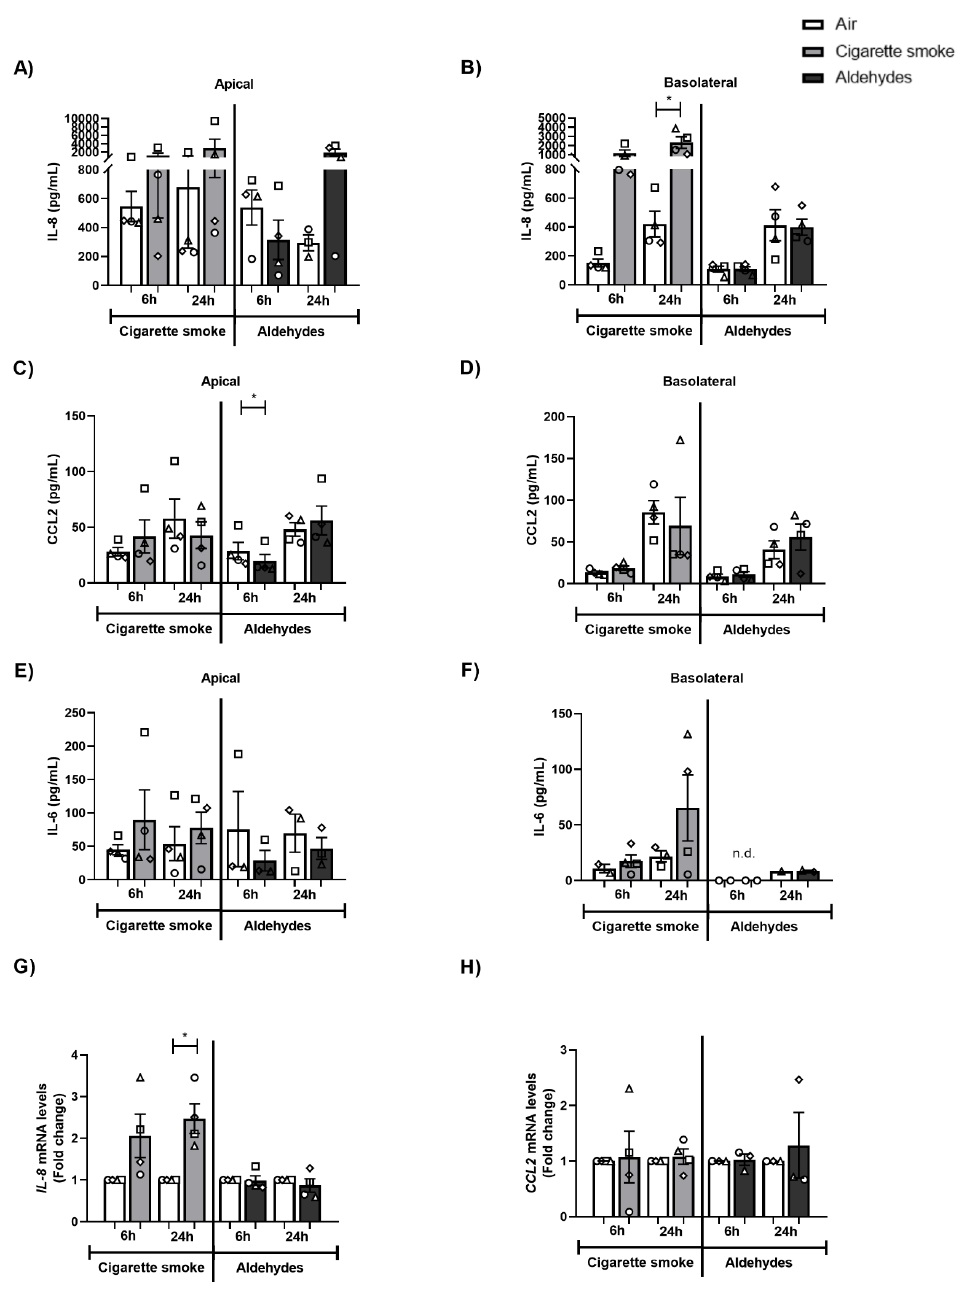
Figure 1. Impact of CS exposure on inflammatory proteins and inflammatory gene expression. Differ- entiated human primary bronchial epithelial cells (PBEC) from non-COPD subjects ( n = 2–4 donors) were exposed to smoke of one Marlboro Red cigarette (CS), or a mixture of acetaldehyde, acrolein, and formaldehyde (at concentrations equivalent to one cigarette), or air (control), under a continuous flow system using a puff-like exposure protocol. Following recovery for 6 h or 24 h, supernatants and whole cell lysates were harvested. Inflammatory protein levels: ( A , B ) IL-8, ( C , D ) CCL-2, and ( E , F ) IL-6 in apical and basolateral supernatants were analyzed. Transcript levels of inflammatory markers ( G ) IL-8 and ( H ) CCL-2 in whole cell lysates were analyzed. Data are presented as mean fold change compared to air control ± s.e.m. The mean values of biological triplicate results per independent donor are represented by open circles, triangles, squares, or diamonds. Statistical differences between CS vs. air and the mixture of aldehydes vs. air were tested using a two-tailed paired parametric t -test. Statistical significance is indicated as * p < 0.05 vs. air